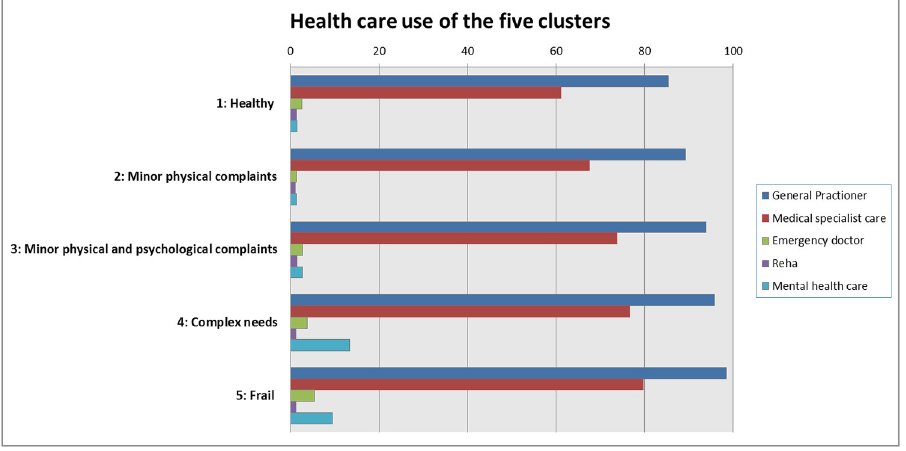
Fig 2. Health care use of the five